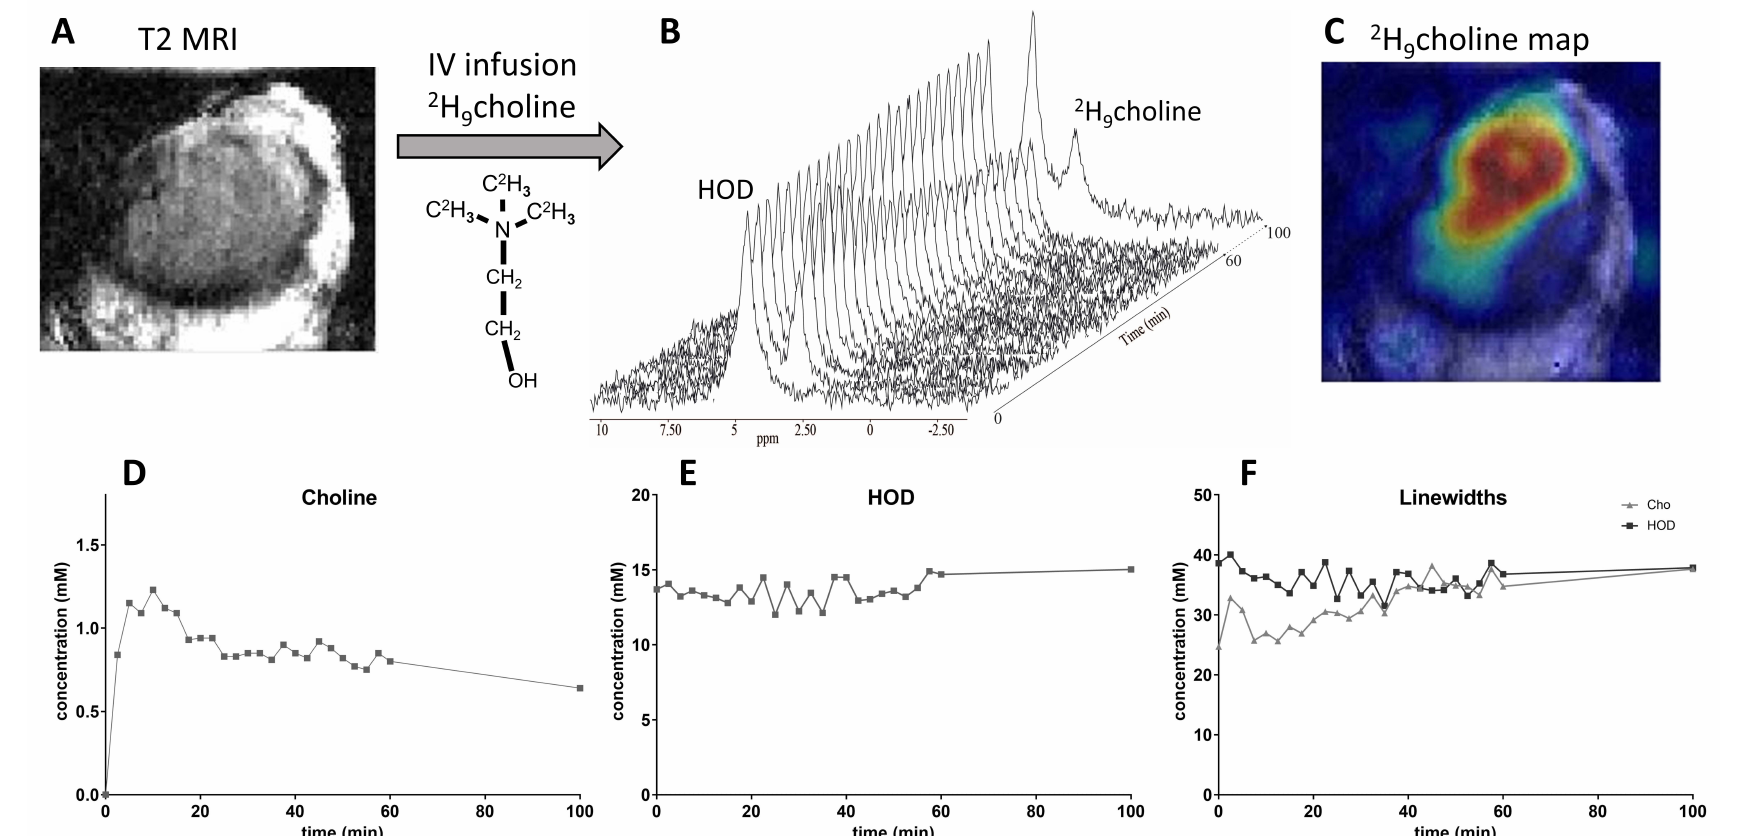
Figure 1. Deuterium MR of a human renal tumor (SKRC17T) subcutaneously grown in a BALB/c mouse. ( A ). T2 MRI of the tumor. The chemical structure of [ 2 H 9 ]choline is also indicated. ( B ). Unlocalized 2 H MR spectra obtained with a surface coil at a time resolution of 2:30 min. The first spectrum recorded before the infusion of choline only shows a natural abundance HOD signal at 4.8 ppm. Immediately after the infusion of a bolus of about 0.2 mL with [ 2 H 9 ]choline, a signal for this compound is observed at about 3.2 ppm. Within ~5 min after the infusion this signal has reached its maximum value and then slowly declines over time. ( C ). A metabolic map of [ 2 H 9 ]choline reconstructed from a high resolution DMI obtained between 60 and 100 min post-infusion. ( D ). [ 2 H 9 ]choline tissue concentration (mM) as a function of time post-infusion. After a rapid initial increase, it slowly decreases over time. ( E ). HOD tissue concentration (mM) as a function of time. Over the measurement period of 100 min the HOD concentration essentially remains constant. ( F ). Fitted linewidths (Hz) of the [ 2 H 9 ]choline and HOD resonances as a function of time. That of HOD essentially remains constant, while that of [ 2 H 9 ]choline